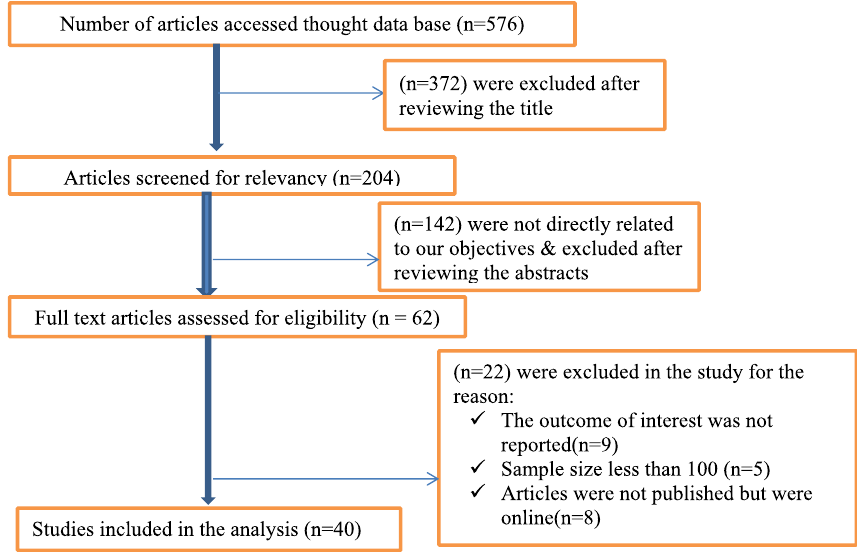
Figure 1. PRISMA flow diagram describing the selection of studies included in the systematic review and meta-analysis of prevalence and determinants of DM in